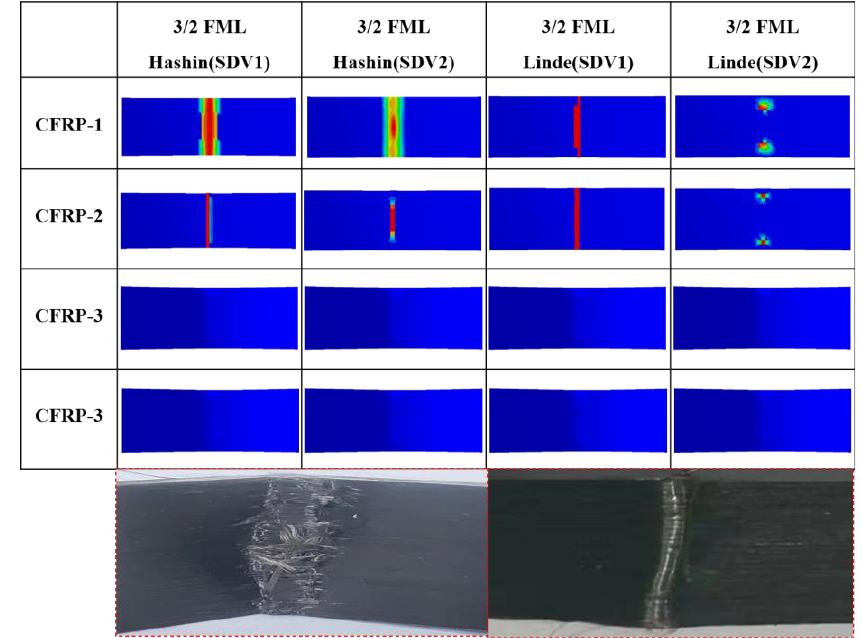
Figure 12. Damage of each CFRP layer in 3/2 FMLs patch